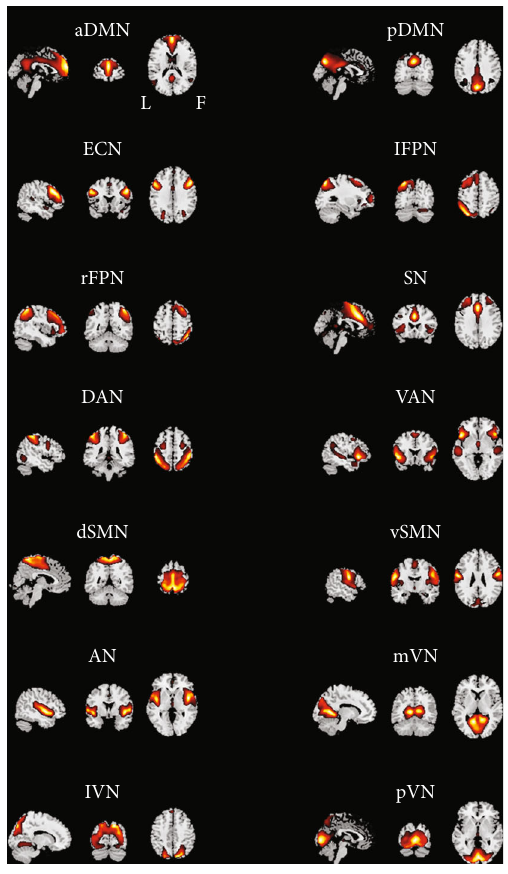
Figure 1: Spatial maps of 14 selected independent